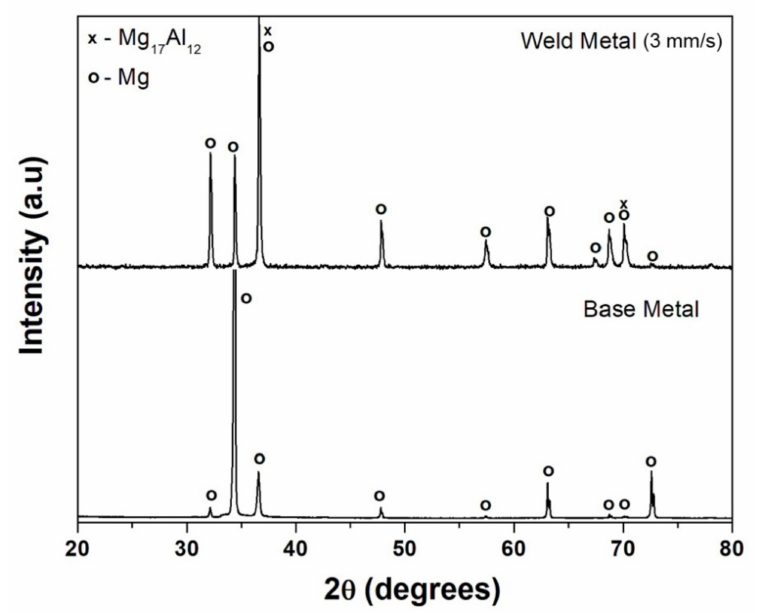
Figure 6. XRD pattern of the weld fusion zone and base metal corresponding to 3 mm/s welding speed.